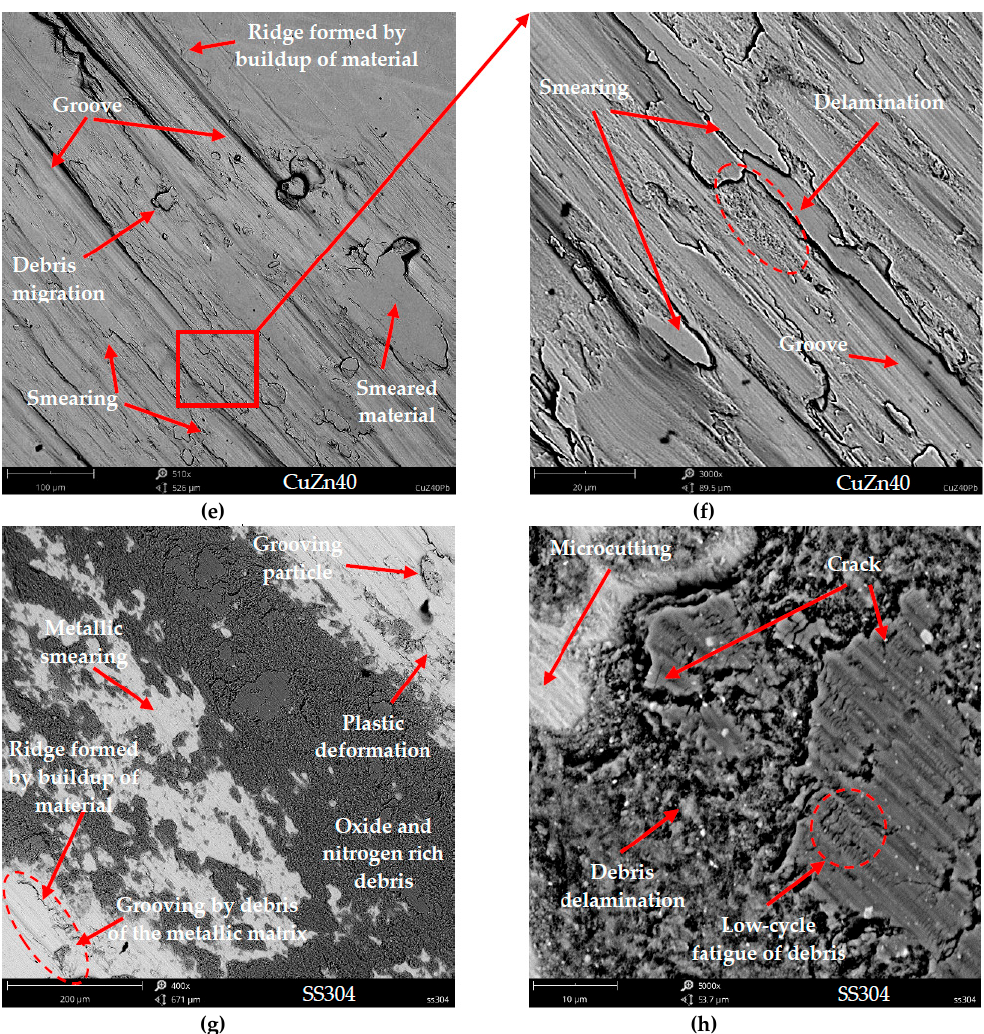
Figure 13. Comparison of the microimages showing the wear track of bulk alloys: ( a , b ) AlCu4; ( c , d ) Cu110; ( e , f ) CuZn40; ( g , h ) SS304. SEM-BSE.